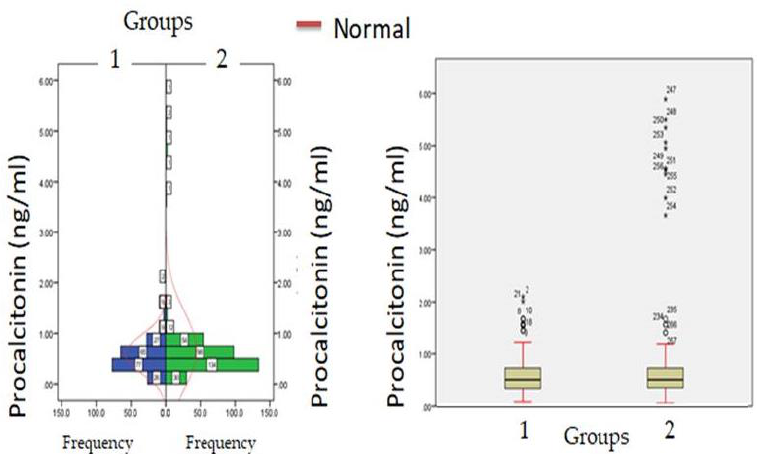
Figure 3. Procalcitonin levels at admission (hospitalization) in patients with normocreatinemia (Group-I) and hypercreatinemia (Group-2).